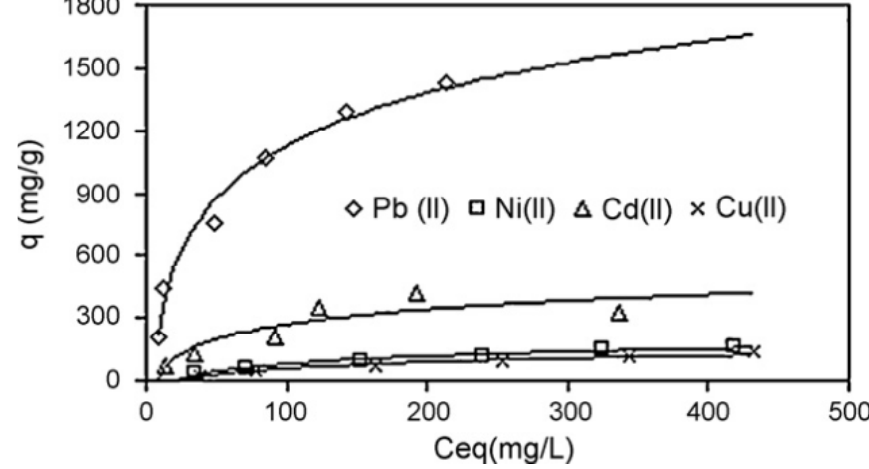
O –PEI800–MMT and ( b ) Fe 3 4